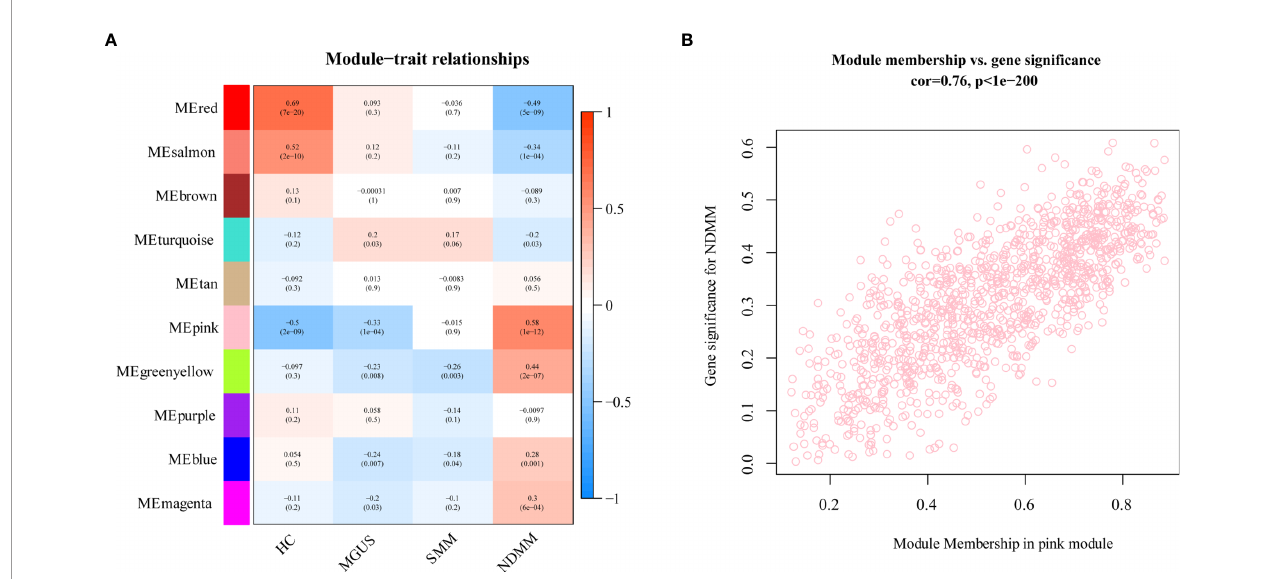
FIGURE 2 | The relationship between modules and PC dyscrasia. (A) Module-trait associations. Each row corresponds to a ME, each column to a stage of PC dyscrasias. The table is color-coded by the corresponding correlation according to the color legend. (B) A scatterplot of GS for weight vs. module membership in the ME